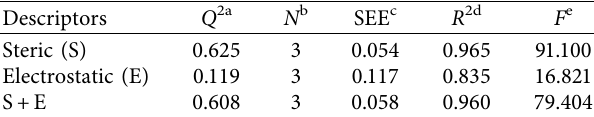
Table 2: Possible CoMFA results.